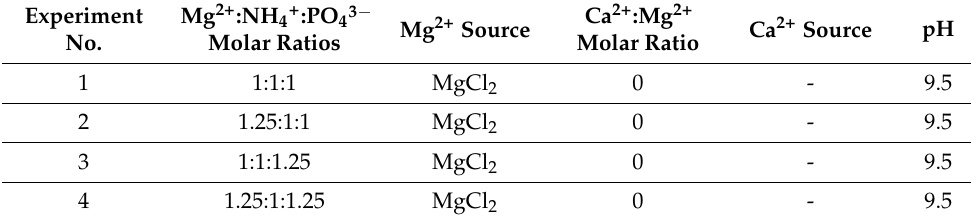
Table 2. Experimental conditions